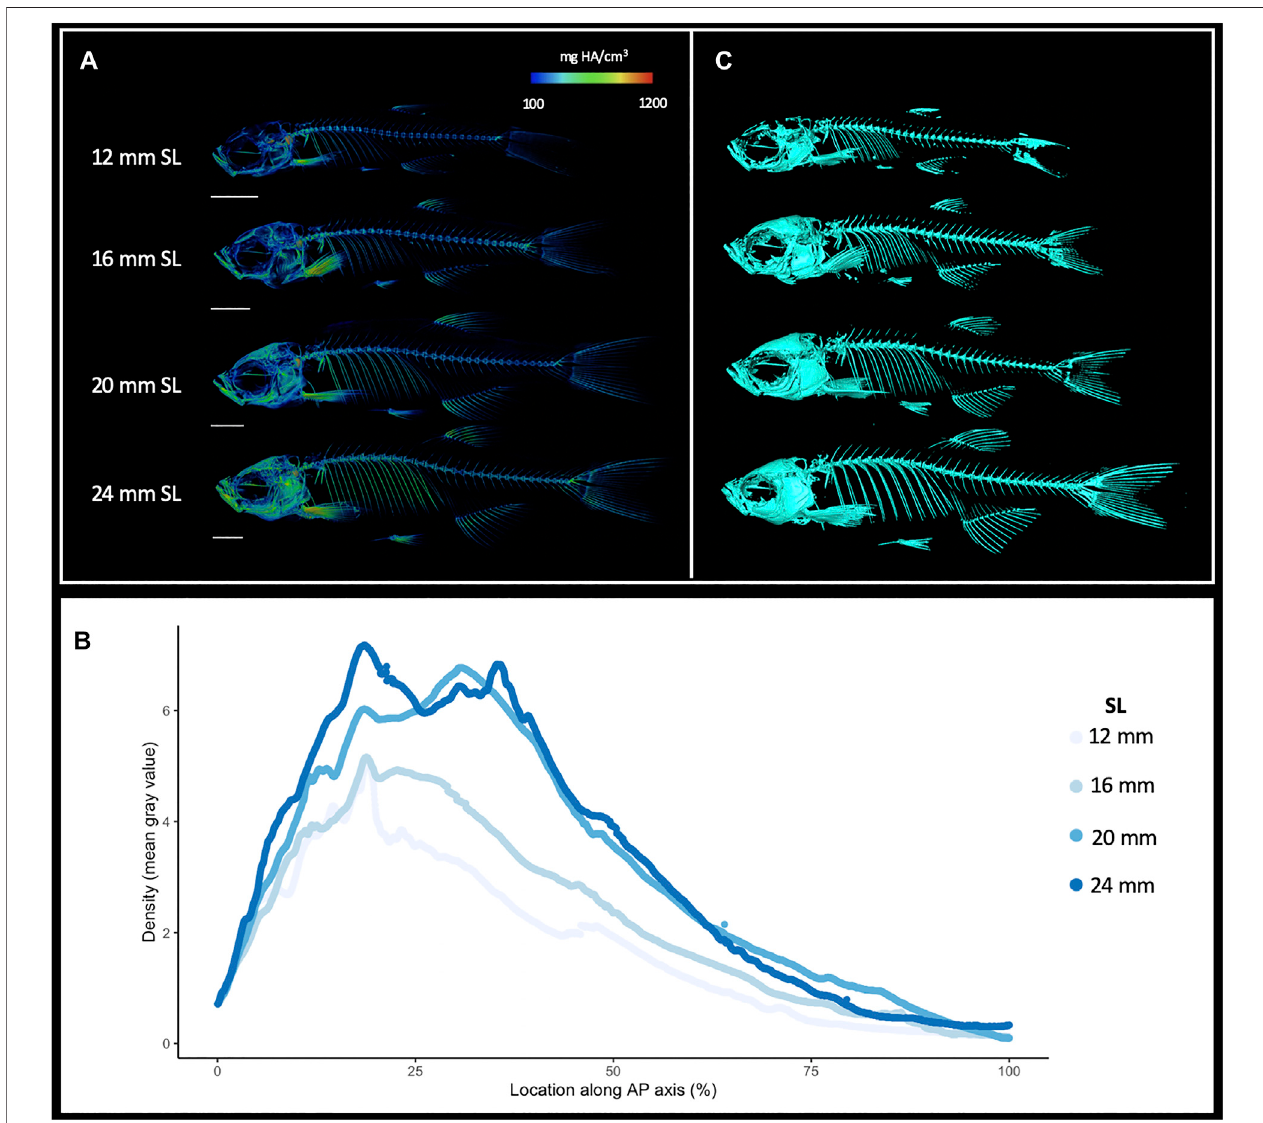
FIGURE2| Increasingskeletaldensity and volume withlineargrowth. (A) ,Relative density renderings ofskeletonsfrom zebra fi shat four differentsizes(12,16, 20, and 24 mm SL). Warmer colors indicate higher density regions. (B) , Average density of zebra fi sh skeleton along the body length of individual zebra fi sh at four sizes. (C) . Volume renderings of zebra fi sh at four sizes. Scale bars, 2